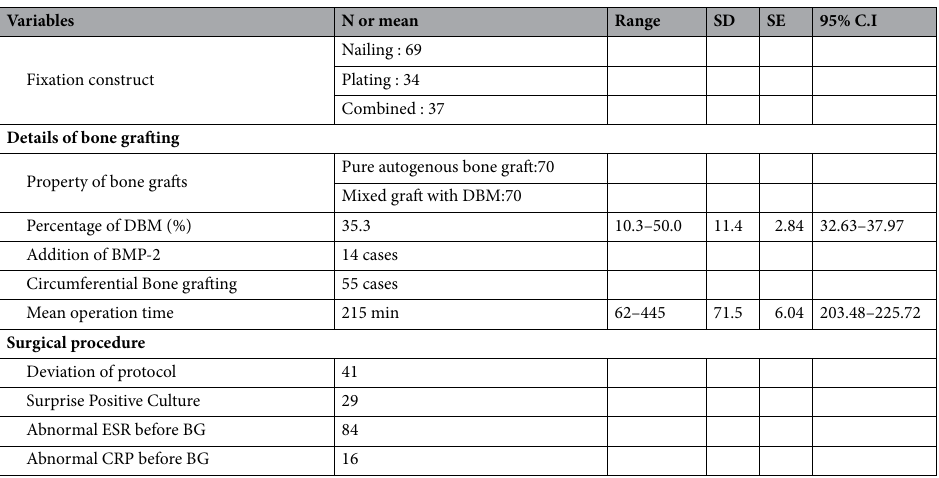
Table 1. Demographic, location and severity of infection, Microorganism, Environment of bone grafting, Details of bone grafting, and surgical procedure in 140 patients. S.D.: Standard Deviation, S.E.: Standard Error,